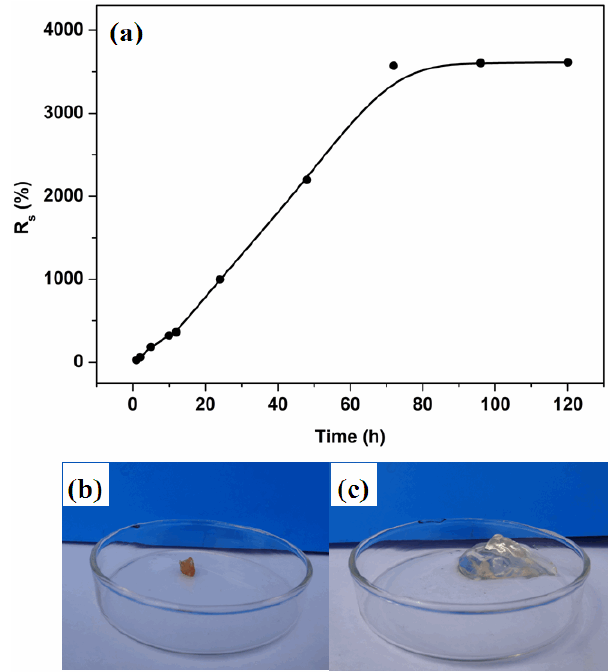
Figure 4. ( a ) Water uptake of the PBMAP hydrogel as a function of time. ( b ) PBMAP hydrogel in dry state. ( c ) PBMAP hydrogel swollen 35 times its own